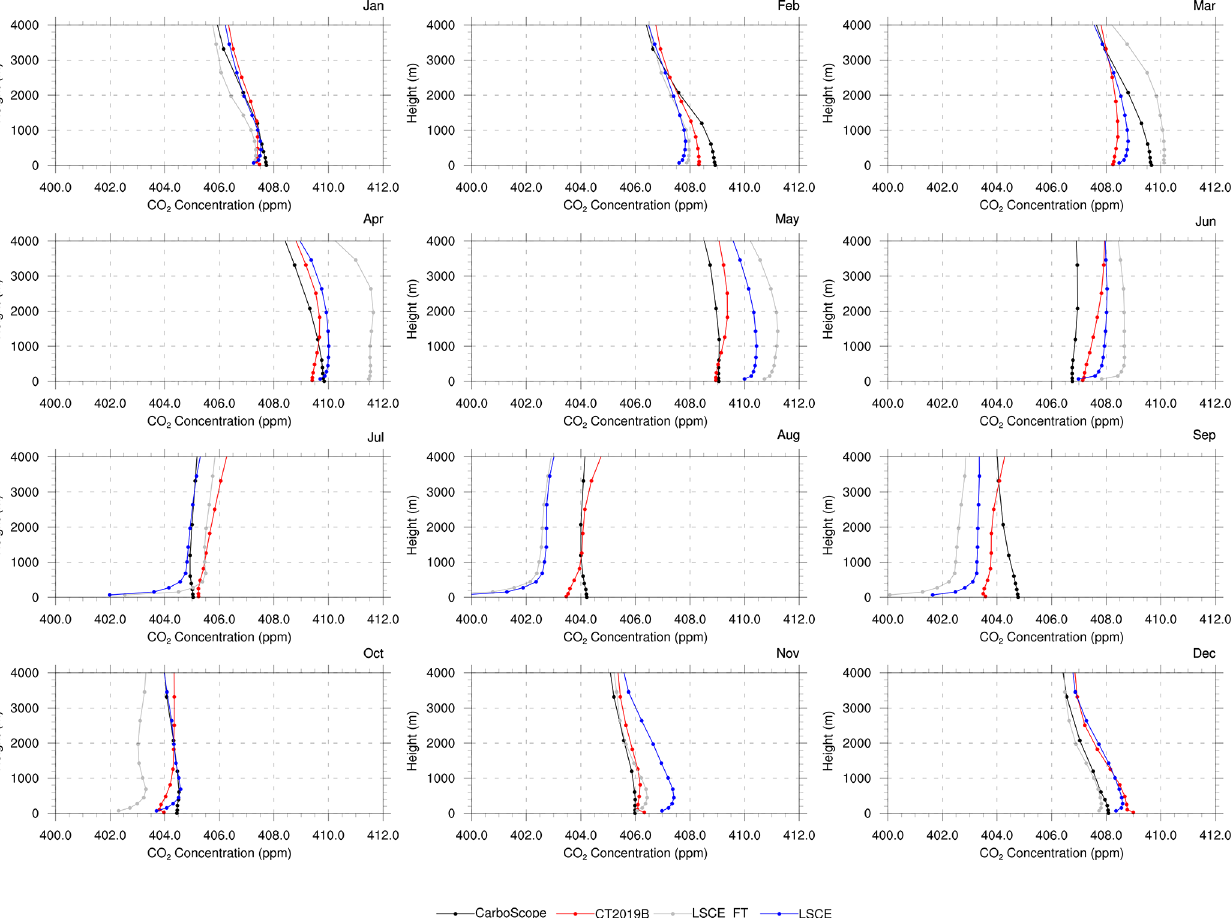
Figure 3. Comparison of average monthly vertical profiles of CO 2 concentration from global atmospheric transport models over the model domain during daytime (11:30 to 16:30LT) in 2017. Panels show data for the respective months, as indicated at the top of each panel.